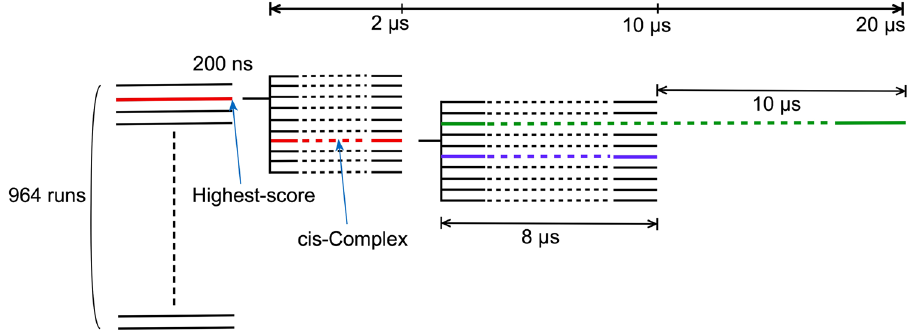
Figure 7. A schematic figure for the MD simulations which started from the free EPR and apo form of